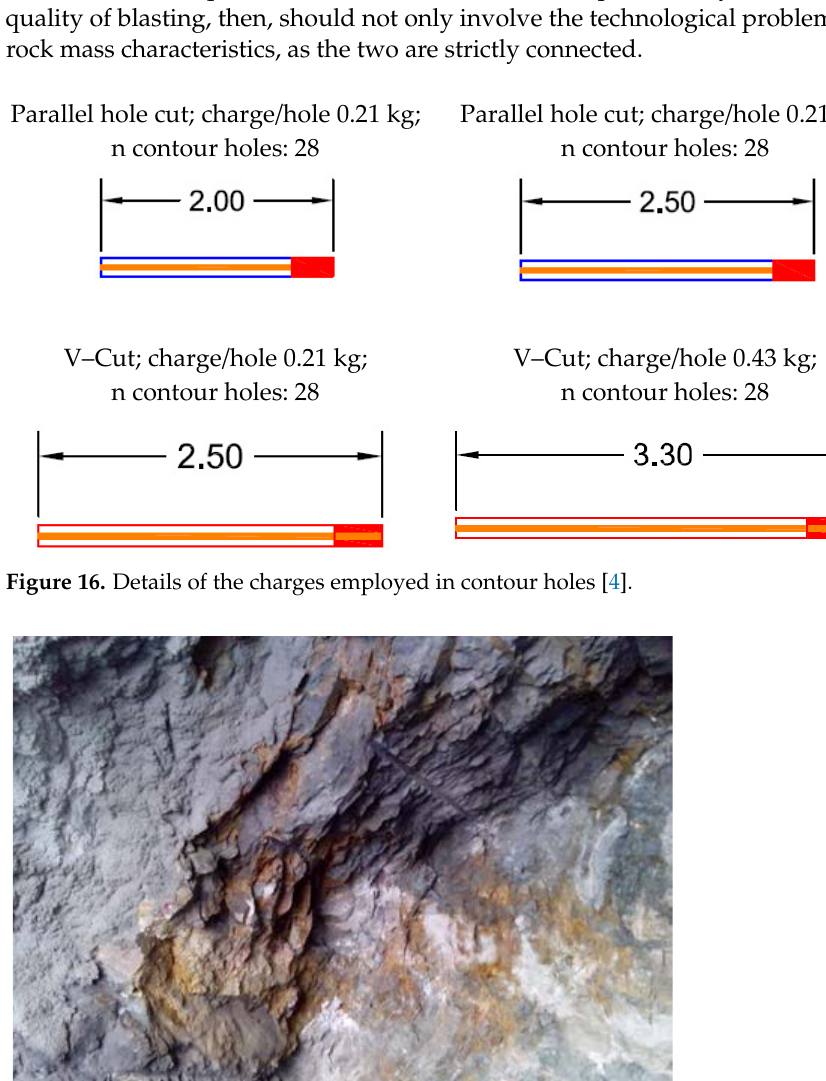
Figure 17. The poor quality of the obtained contour is noticeable [4].